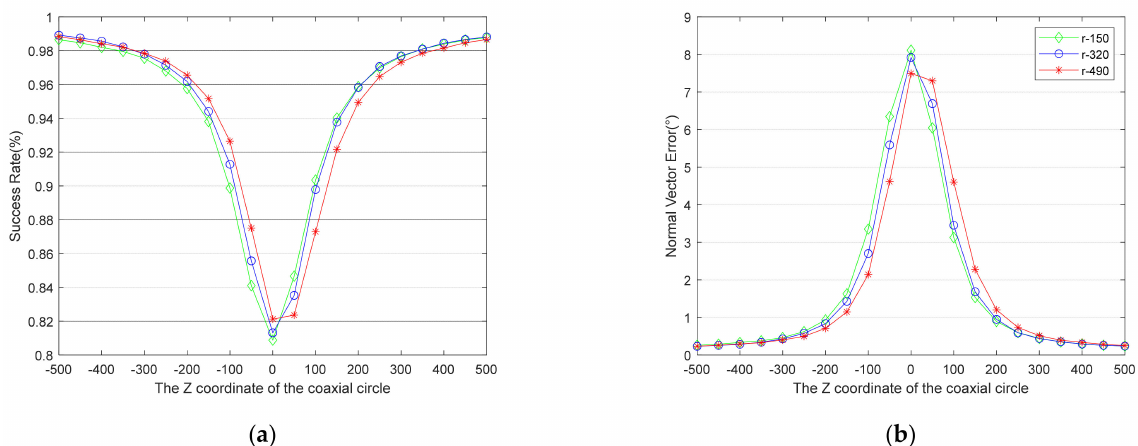
Figure 7. This is a figure about the relationship between the performance of the proposed algorithm and the target’s spatial structure when the z -axis coordinate of the target is 7 m. ( a ) The curves of the success rate. ( b ) The curves of the normal vector’s angle error.